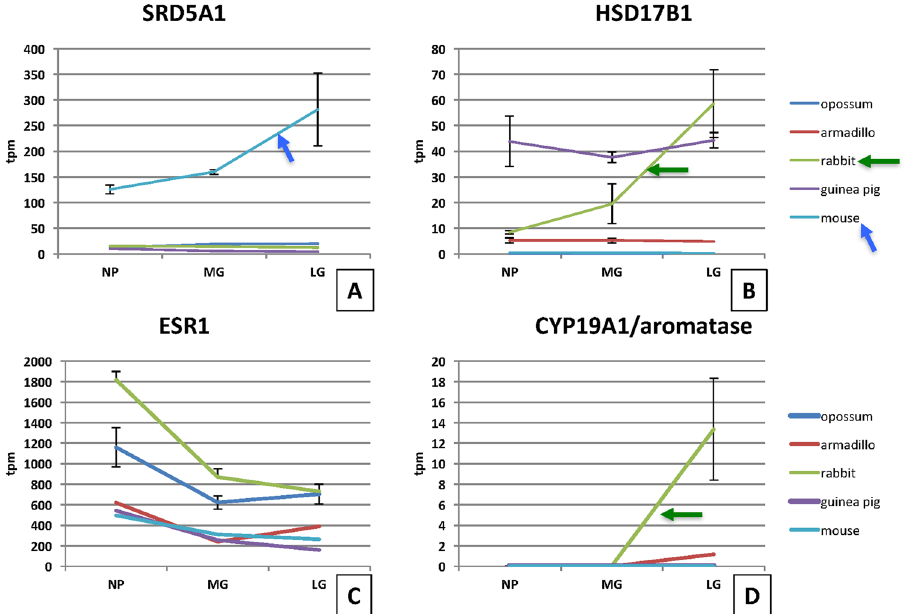
Figure 2. mRNA expression profiles of some genes related to progesterone and estrogen metabolism. ( A ) SRD5A1 is an enzyme that converts progesterone to di-hydroprogesterone and is necessary for mouse cervical remodeling. This gene is only expressed in the mouse in increasing amounts towards term. ( B ) HSD17B1 has been reported to have two enzymatic activities, converting estrone into estradiol, as well as hydroxylating progesterone at the C20. It is expressed in guinea pig and rabbit but only up-regulated towards term in rabbit. ( C ) The estrogen receptor alpha gene ESR1 is expressed in all animals studied and tends to be higher in non- pregnant animals than during gestation. ( D ) CYP19A1 is the gene for aromatase, the key enzyme for the synthesis of estrogens. This gene is not expressed in most animals with the notable exception of rabbit, which shows a strong increase towards term suggesting local production of estrogen towards term. This interpretation is further supported by the elevated expression of HSD17B1 ( B ) also uniquely in